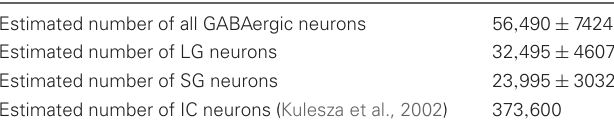
Table 1 | Stereological estimates of GABAergic neurons in the IC (mean ± S.D., N =